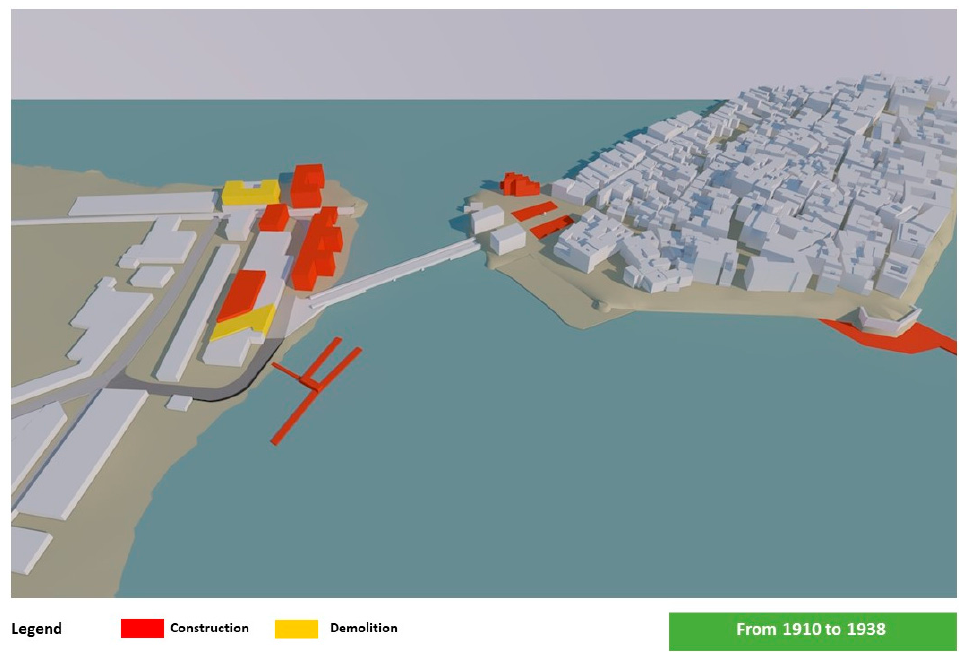
Figure A4. Three-dimensional model of differences between volumes built or demolished—from 1910 to 1938.